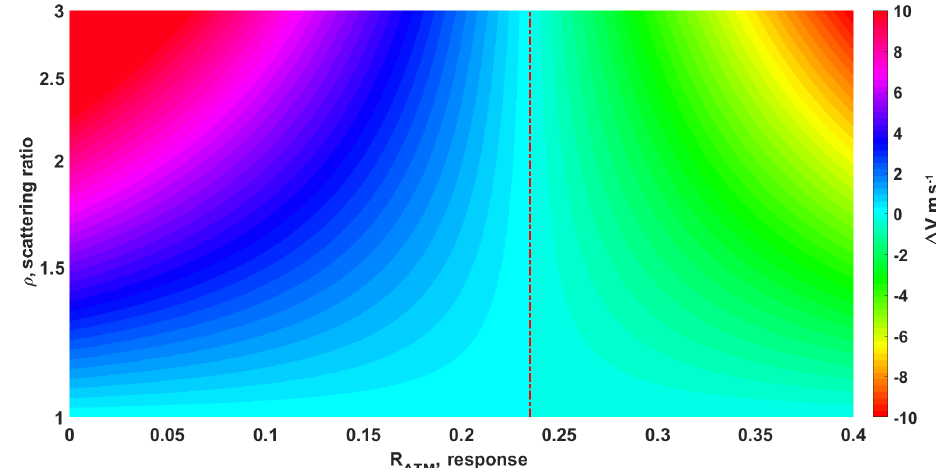
Figure 2. Simulation of LOS wind velocity errors (cid:49)V MC induced by Mie contamination and a molecular line shape at T = 223K and P = 301hPa. The x axis and y axis represent the response value R ATM and scattering ratio ρ , respectively. The dashed red line corresponds to the response value with minimum (cid:49)V MC at each scattering